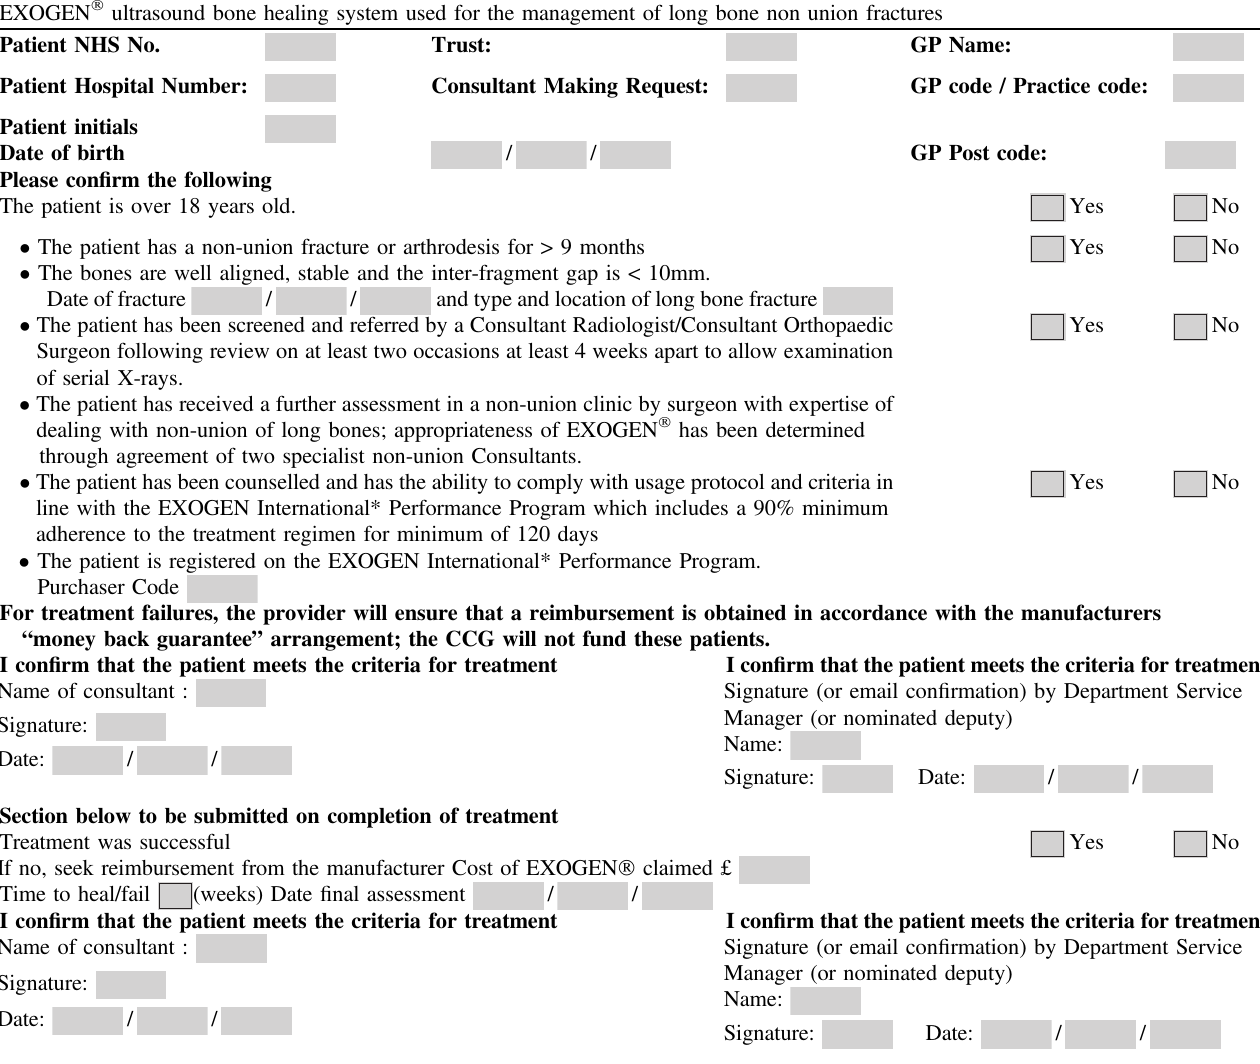
Table A1. EXOGEN device suitability screening tool to be used to assess patient suitability prior to commencing EXOGEN and assessing for successful completion